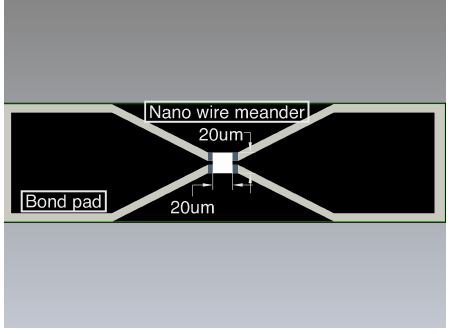
Figure 16. Baseline SNSPD sensor prototype autoCAD drawing.